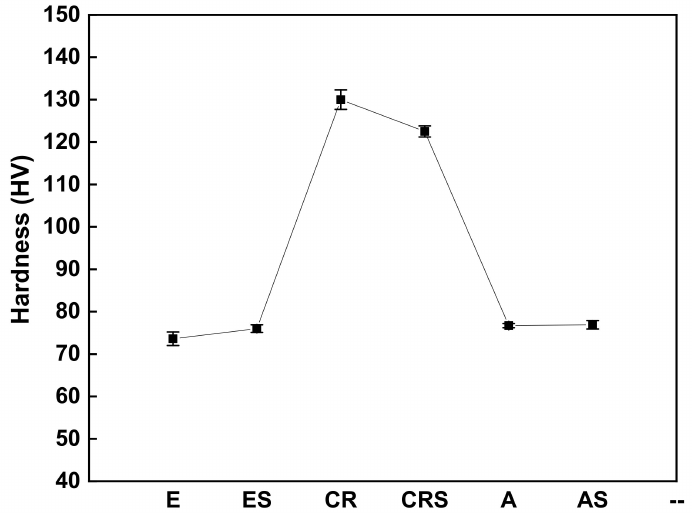
Figure 7. Vickers hardness results of Al-6Mg alloy for each manufacturing process.